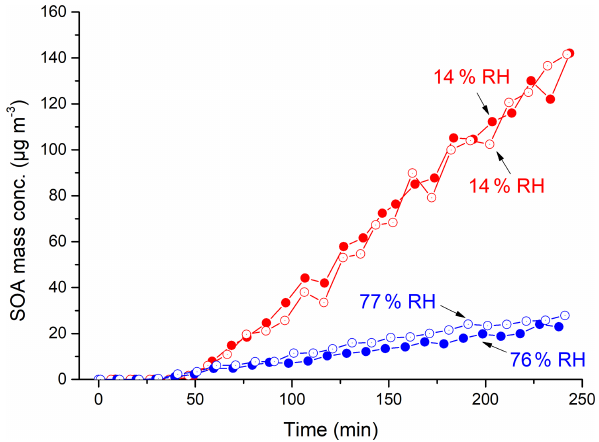
Figure 1. Mass concentration time profiles of SOA from m - xylene–H 2 O 2 photooxidation at 14% (Exps. 3–4) and 76%–77% (Exps. 10–11) RH (corrected by particle wall loss and for the amount of LWC in